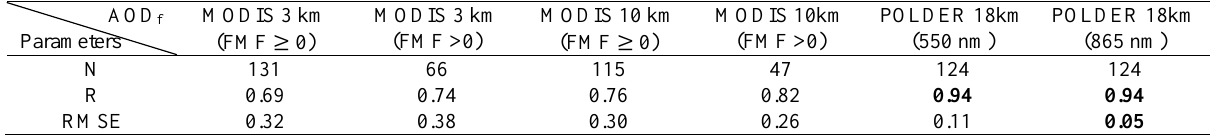
Table 1. Statistical summary for validation of MODIS and POLDER AOD f products. The best statistics have italic bold